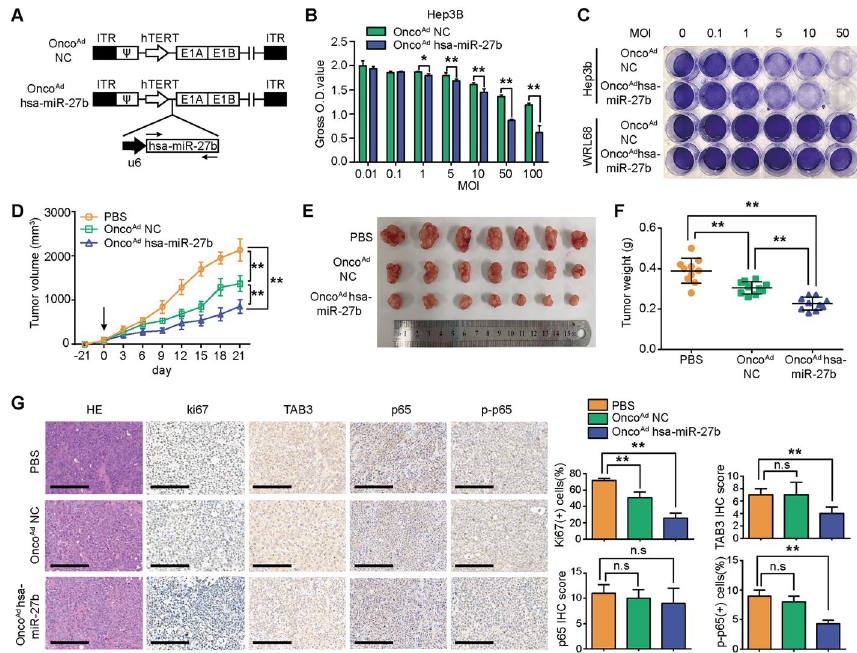
Fig. 7 Onco Ad hsa-miR-27b suppressed HCC growth in vitro and in vivo. A Schematic diagram of the structures of the Onco Ad . B Hep3B cells were treated with Onco Ad hsa-miR-27b and Onco Ad NC at the indicated MOI. After 48 h, cell viabilities were measured by CCK-8 assays ( n 5, unpaired t -test). C Hep3B = and WRL68 cells were infected with Onco Ad at the indicated MOIs for 2 days. Images of cells stained with crystal violet indicated the cytopathic effect of Onco Ad hsa-miR-27b and Onco Ad NC. D Growth curve of subcutaneous tumours with intra-tumoural injection of PBS ( n 7), Onco Ad NC ( n 7) or Onco Ad hsa-miR-27b = = ( n 7). Onco Ad were intra-tumourally injected every 2 days after inoculating subcutaneous tumours for = 21 days (Day 0); PBS was injected as a control. The arrow represents the first action of intra-tumoural injection, two-way ANOVA. E and F Macroscopic images and quantification of tumour weights of the Hep3B xenografts treated with PBS ( n 7), Onco Ad NC ( n 7) or Onco Ad hsa-miR-27b ( n 7) at 21 days post-intra-tumoural = = = injection, one-way ANOVA. G Representative images of H&E staining and IHC staining of the indicated protein in Hep3B xenografts; scale bar, 200 μm. Quantification of Ki-67 and p- p65 -positive cells, as well as IHC scoring of TAB3 and p65 ( n 7, one-way ANOVA). B and C were repeated three times. * p < 0.05, ** p < 0.01. Data are = shown as mean SD. NC, negative control; Onco Ad , oncolytic adenovirus. MOI, multiplicities of infection; ITR, ± inverted terminal